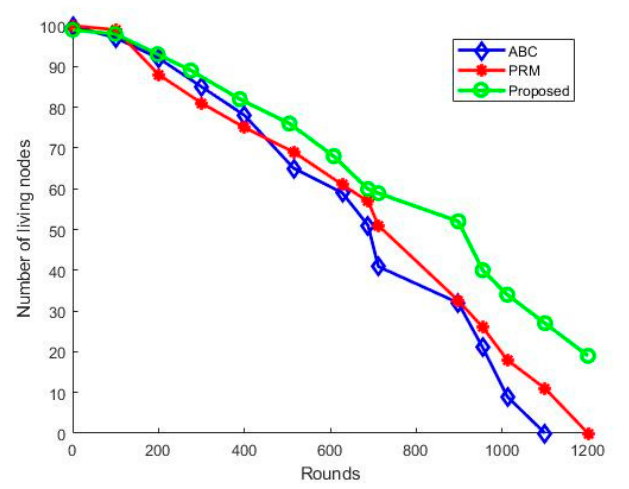
Figure 7. Network lifetime.